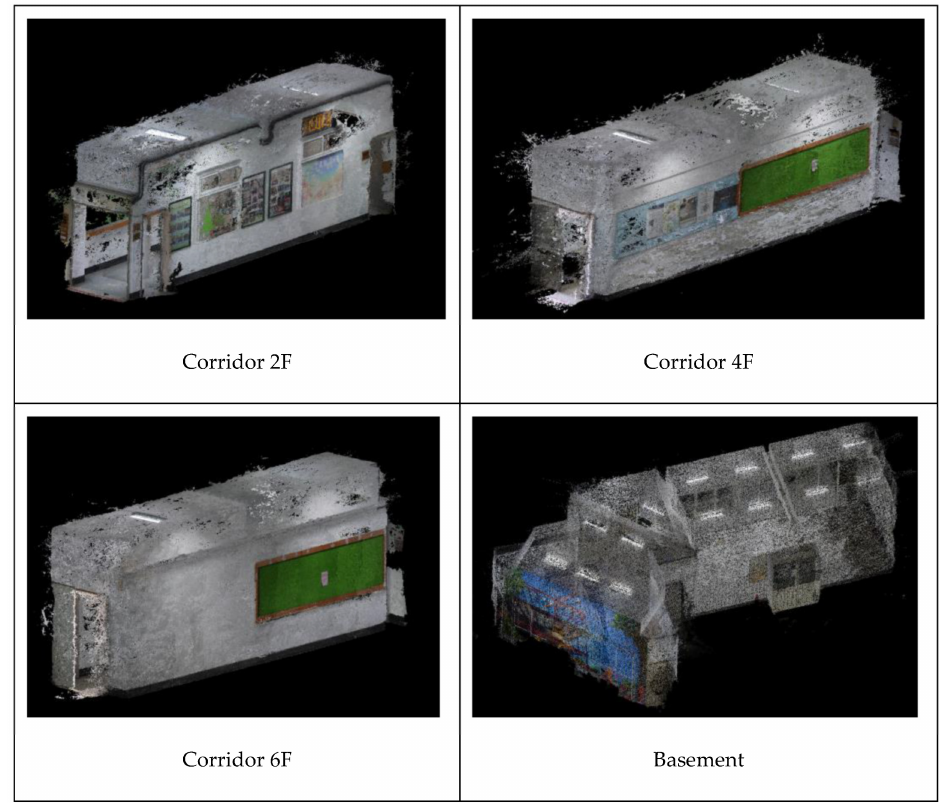
Figure 4. Three-dimensional point cloud results of test area. Four experimental areas, the corridor of 2F, 4F, 6F, and the basement of the civil engineering